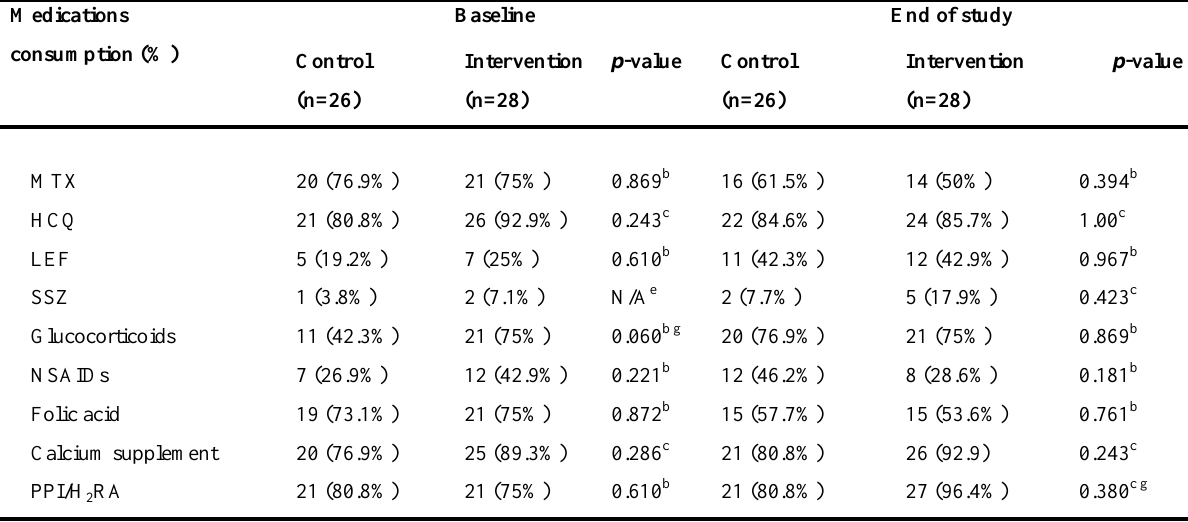
H 2 RA, H 2 Receptor antagonist; HCQ, hydroxychloroquine; LEF, leflunomide; MTX, methotrexate; NSAIDs, Non-steroidal anti- inflammatory drugs; PPI, proton pump inhibitor; SSZ, sulfasalazine.